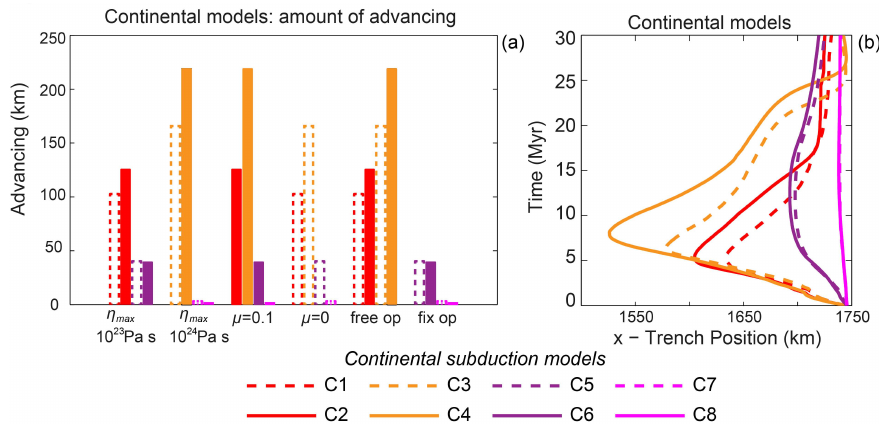
Fig. 6. (a) Amount of advance for all continental models grouped by the changing parameters: free op = free overriding plate, fix op = fixed overriding plate. η max is the maximum viscosity and µ is the friction coefficient. (b) is trench migration of all continental